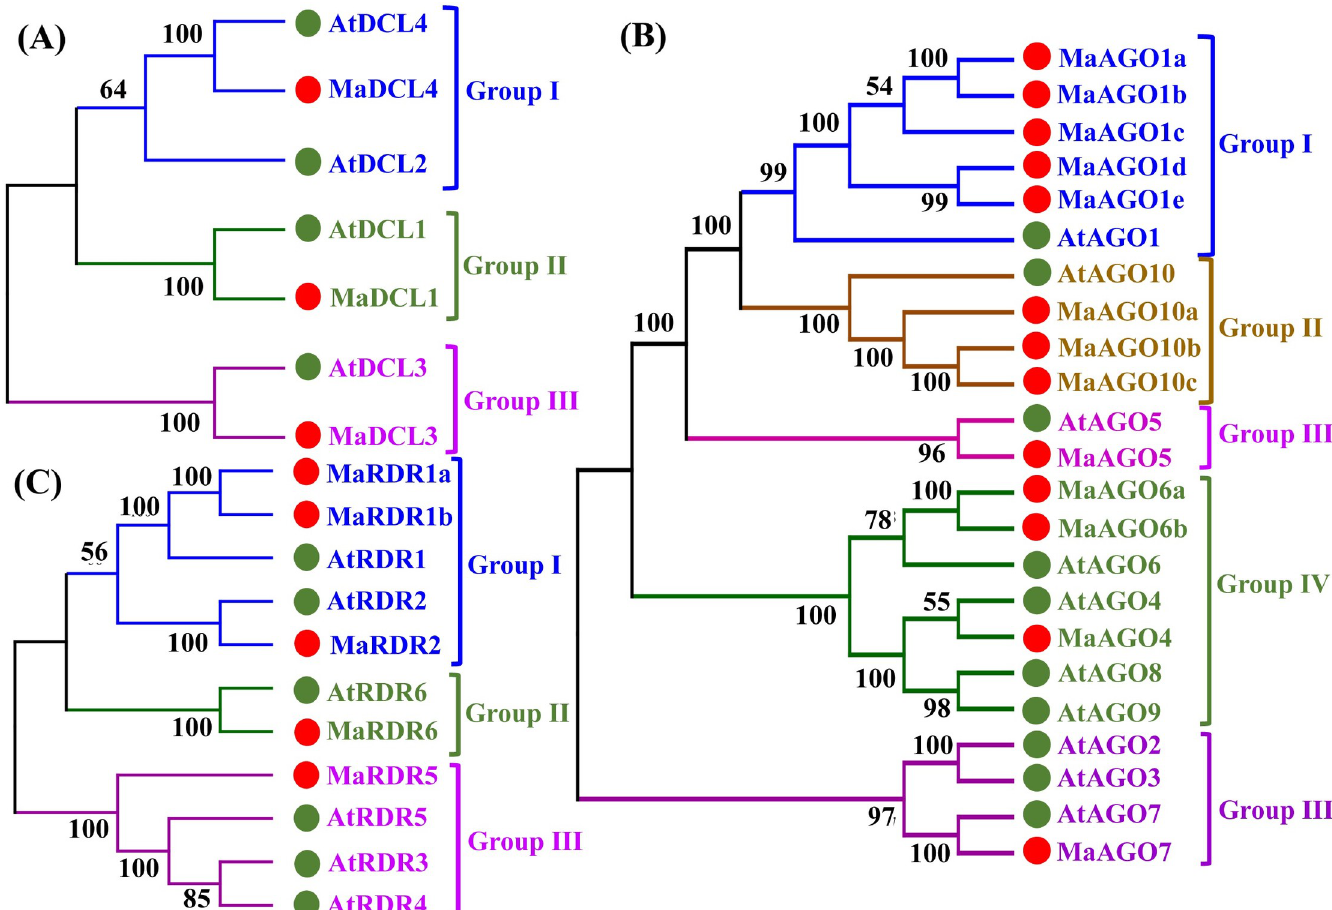
Fig 5. Phylogenetic tree for (A) DCL proteins (B) AGO proteins and (C) RDR proteins from M . acuminata and Arabidopsis . All the phylogenetic trees were constructed using the neighbor-joining method and the numbers at the nodes indicate the percentages of bootstrap values from 1000 replications. The accession number and the abbreviations of proteins from M . acuminata are tabulated in (Table 1) while A . thaliana are given in section 2.1. In phylogenetic tree, different groups are represented by different colors; red circles are mentioned genes of M . acuminata and green circles are mentioned genes of A . thaliana .